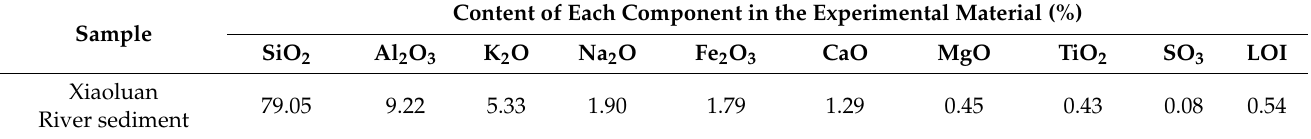
Table 3. Chemical composition of the Xiaoluan River sediment